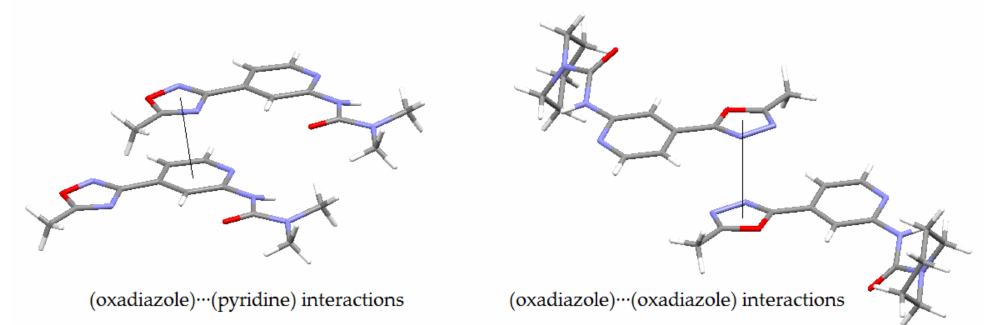
Figure 8. Non-covalent interactions (oxadiazole) ··· (pyridine) and (oxadiazole) ··· (oxadiazole) in N-pyridyl ureas with 1,2,4- and 1,3,4-oxadiazole